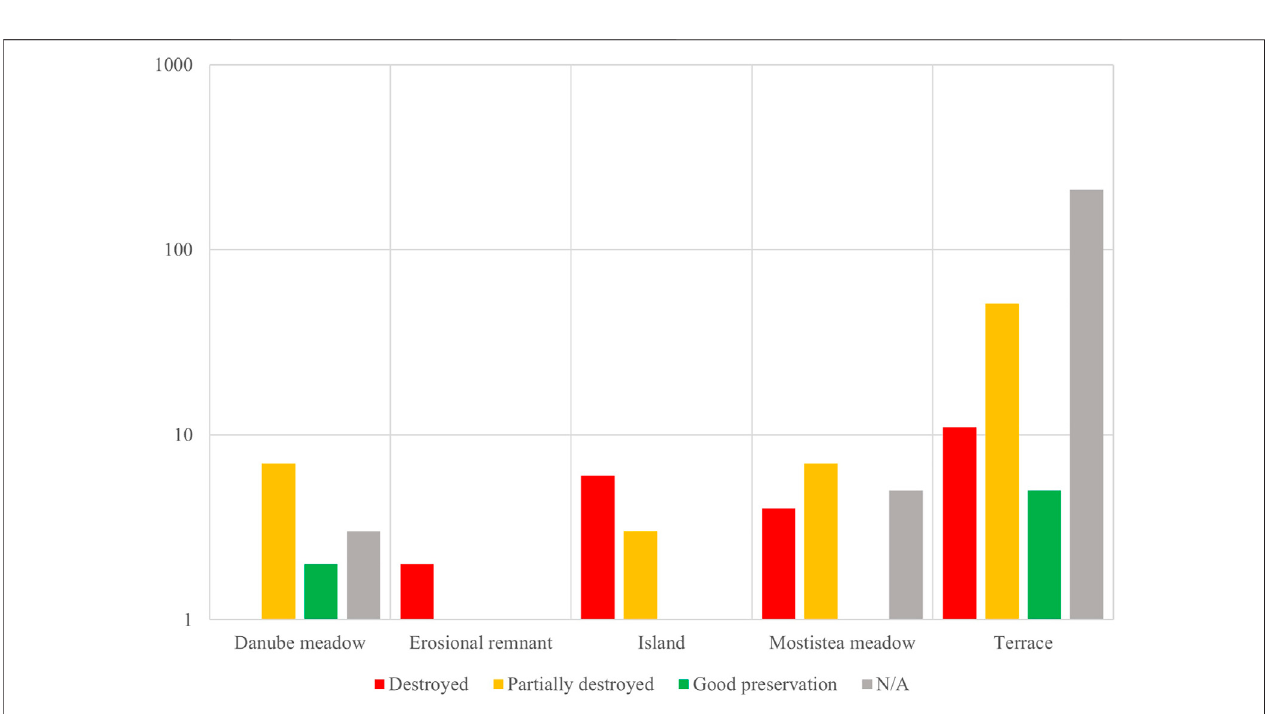
FIGURE 11 | Conservation status distribution of sites by landform units (literature data)